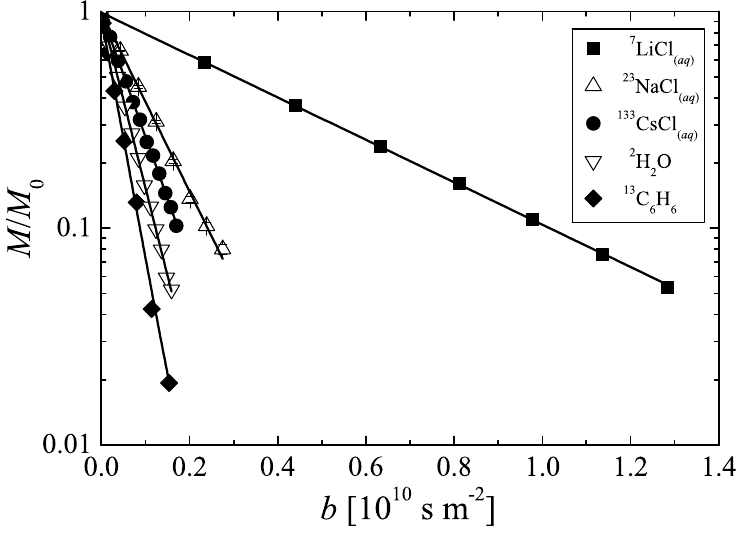
Figure 2. Pulsed field gradient calibration and performance tests of the X-observe probe equipped with a z -gradient coil for NMR diffusion studies. NMR spin echo attenuations due to self-diffusion of Li + , Na + , Cs + in aqueous solutions as well as of bulk deuterated water and 13 C enriched benzene (see legend) observed using 7 Li , 23 Na , 133 Cs , 2 D , 13 C and 2 H resonance,